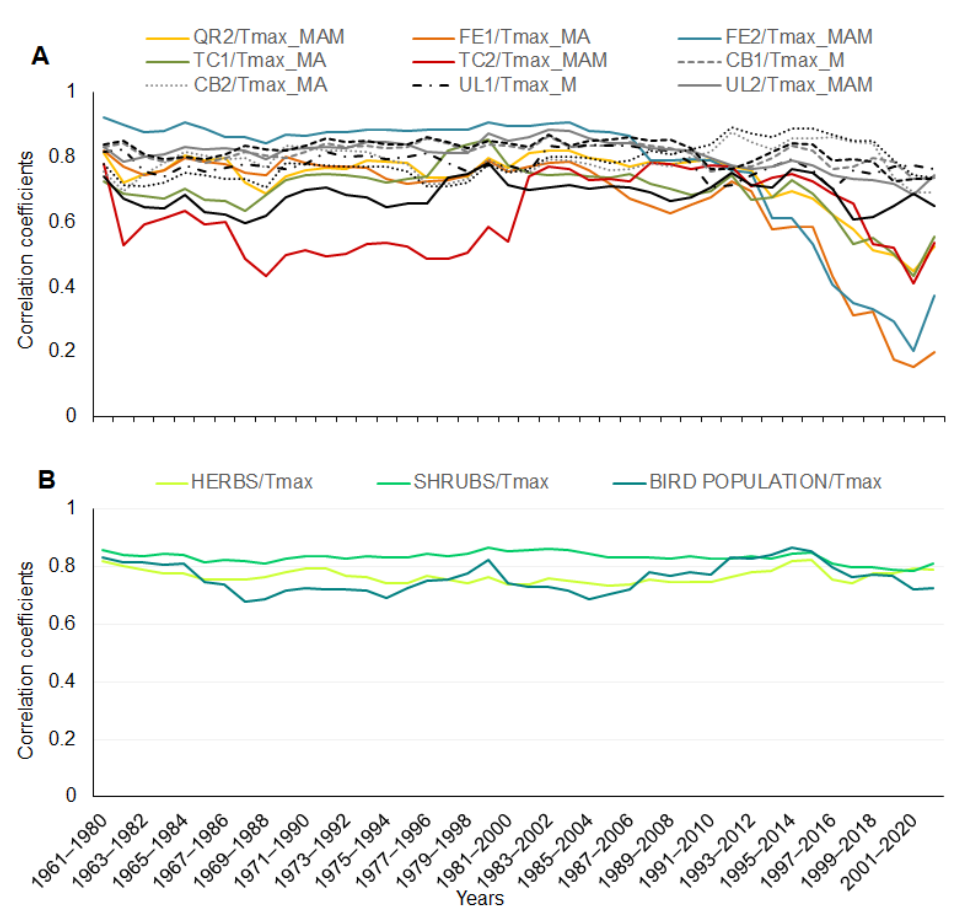
Figure 4. Running correlation for tree phenophases with maximum temperature in the 20-year periods ( A ). Abbreviations for species and temperature are explained in Table 2. Correlation in the 20-year periods for average values of phenophases for herbs, shrubs, and bird species of an ecosystem with maximal temperature in March and April ( B ).